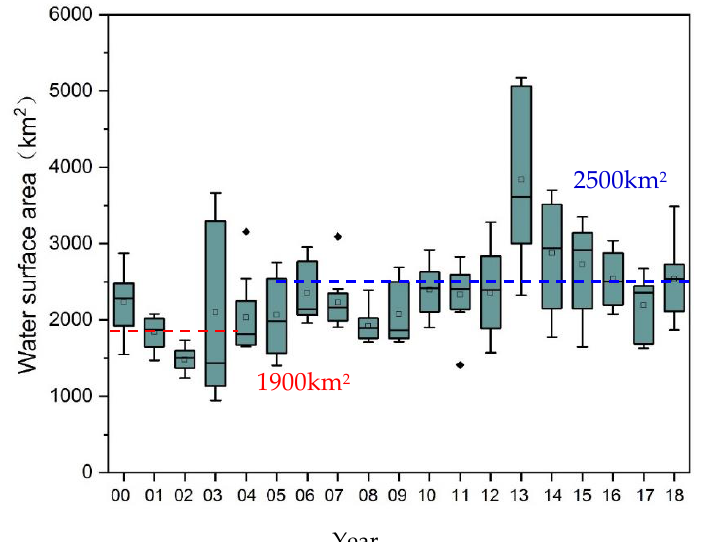
Figure 8. Annual average and variation of the total open water surface area during 2000 and 2018 in the Nenjiang River Basin, Northeast China. The red line shows the average surface area before 2005 and the blue line shows the average after 2005. Each boxplot illustrates the median and inter-quartile range and the whiskers indicate minimum and maximum values.